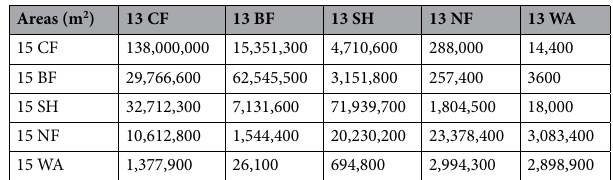
Table 1. The projection areas of the curved surface in the changed area.